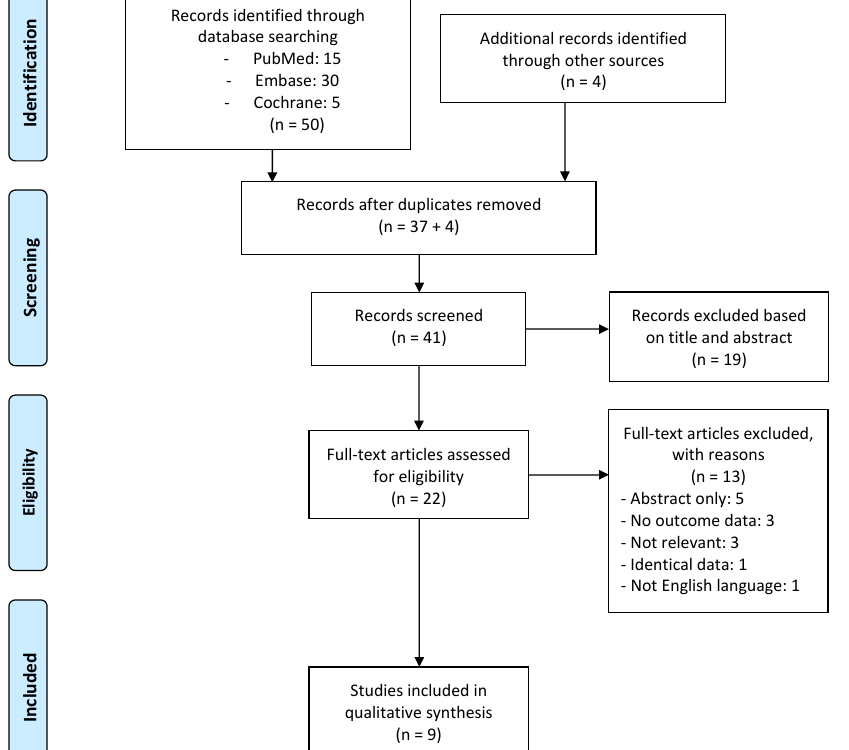
Figure 1. PRISMA flow of studies included in our review.